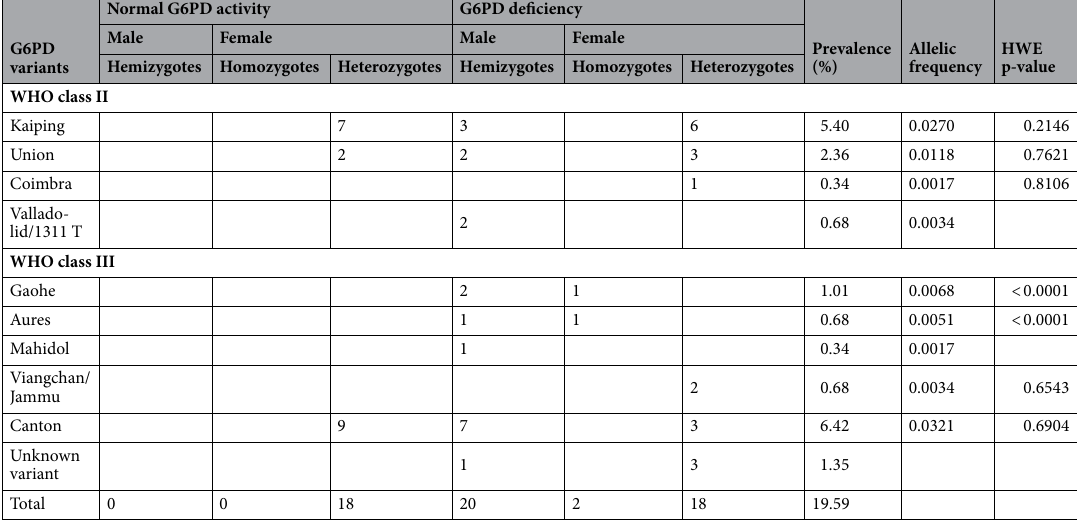
Table 2. Prevalence of G6PD variants in Lue ethnic